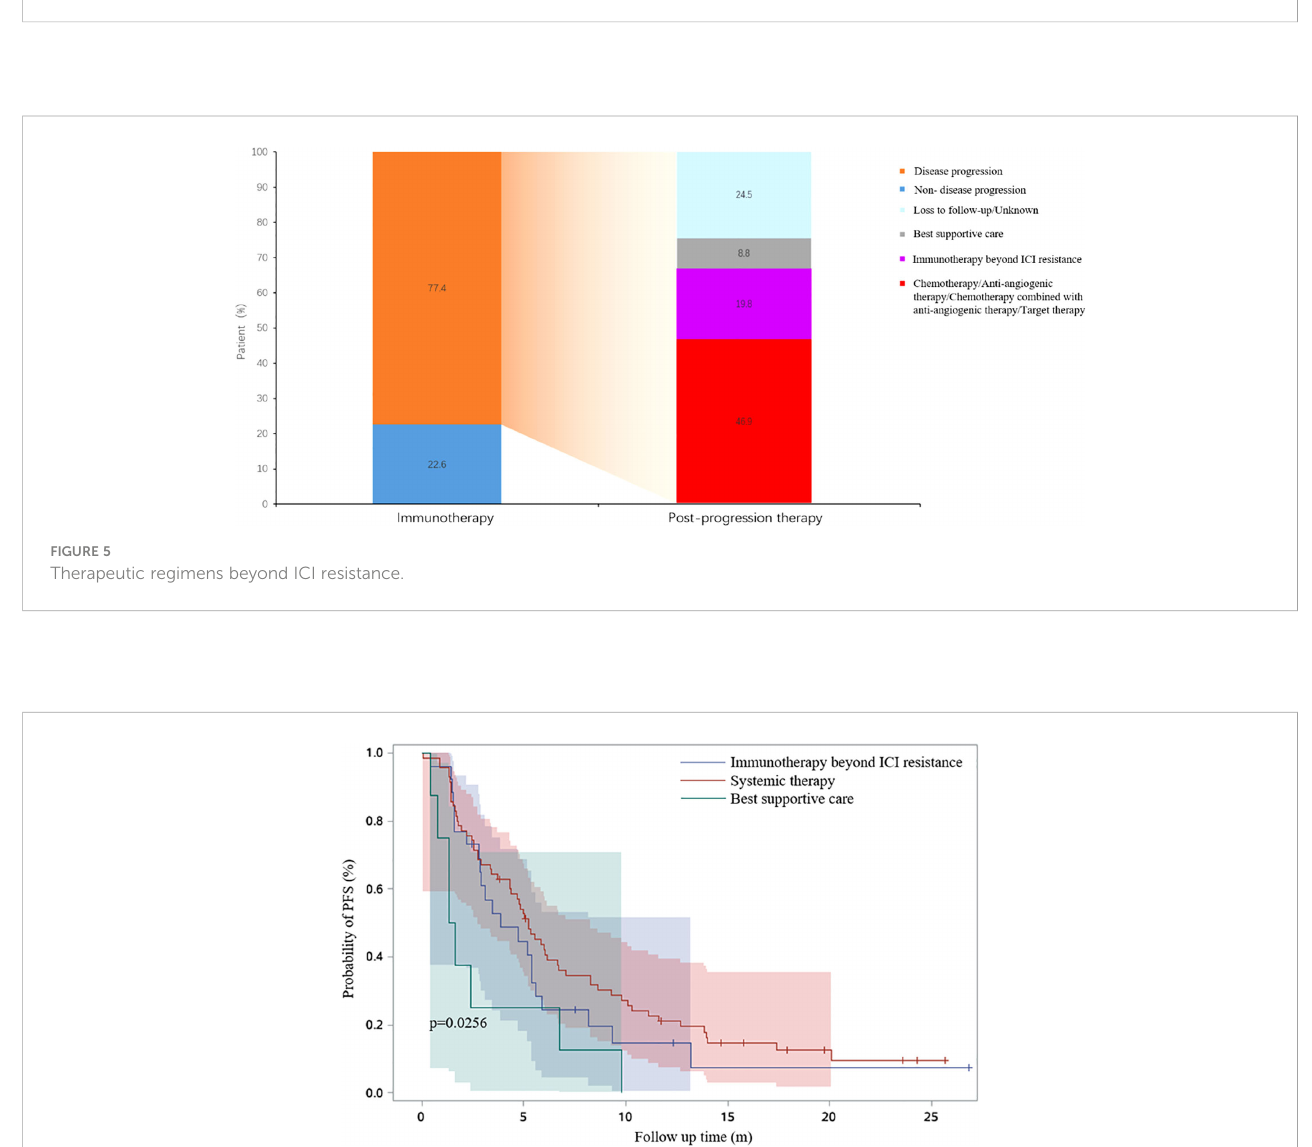
FIGURE 4 Clinical characteristics of ICI resistance. (A) Distribution of intra/extra-pulmonary progression; (B) Distribution of oligo/multi-progression; (C) Distribution of progression site.